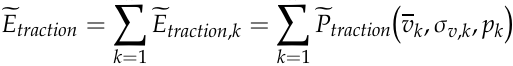
Figure 8. Power estimator assessment for the 10 INRETS driving cycles: ( a ) (cid:1842) (cid:3047)(cid:3045)(cid:3028)(cid:3030)(cid:3047)(cid:3114)(cid:3042)(cid:3041) (cid:3364)(cid:3364)(cid:3364)(cid:3364)(cid:3364)(cid:3364)(cid:3364)(cid:3364)(cid:3364)(cid:3364)(cid:3364) (squares) and